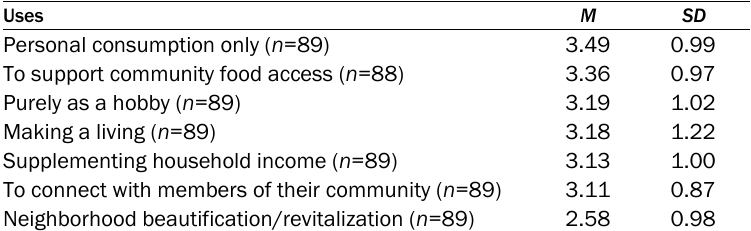
Table 7. How Local Food Producers in Respondents’ Communities are Using Their Products